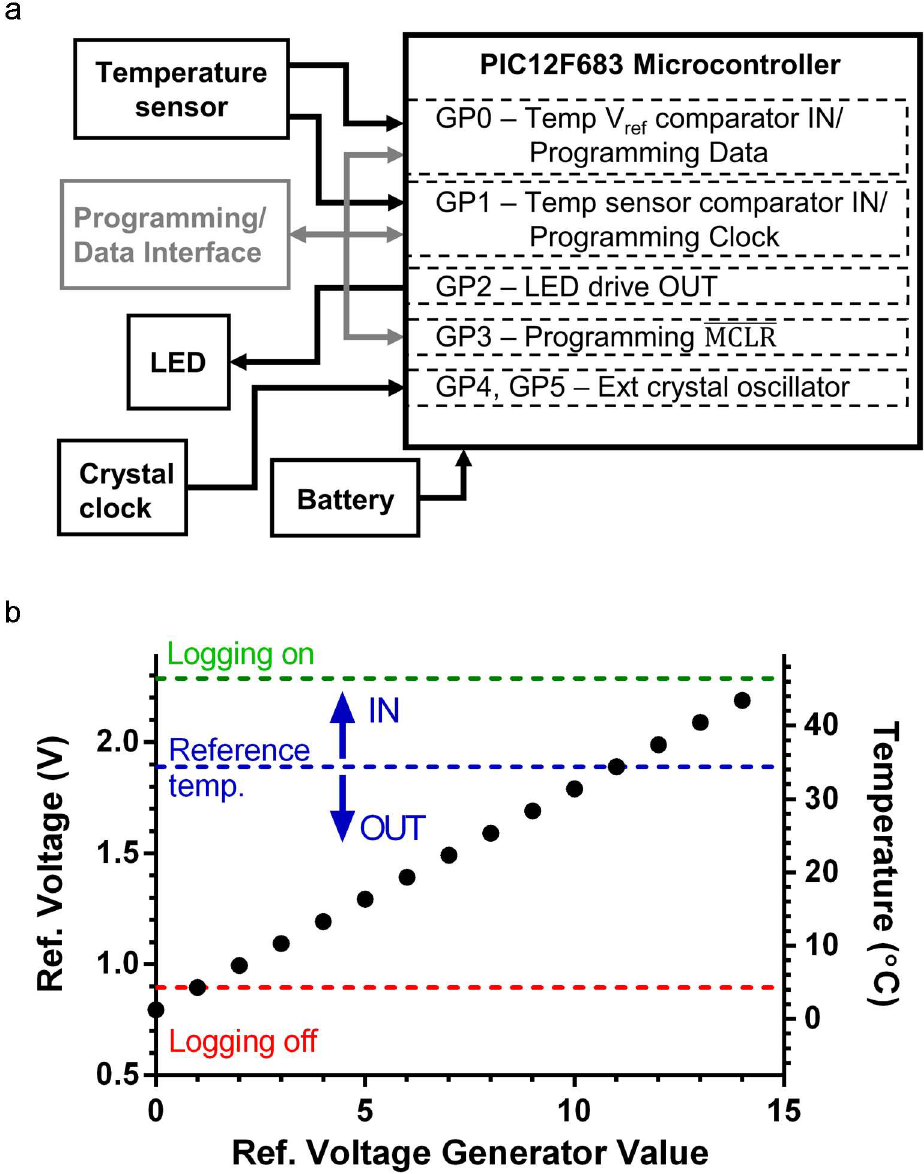
Fig 2. Electronics module design and function. (a) Diagramof adherenceIVR electronicsmodule showingmajor functionalcomponents (boxes) and dataflow(arrows). (b) Plot showing relationshipsbetween reference temperature, comparator reference voltage(V ref ), and the 4-bit V ref generator parameter. Each point represents a reference temperature that is set in software by the generator4-bit value (0–15). Here a generatorvalue of 11 is set to select a reference temperature of 34˚C. Dotted lines indicate V ref values selectedfor IN/OUT determinationand “LoggingOn” “LoggingOff” functionality in the in vitro and in vivo testing of adherence IVR